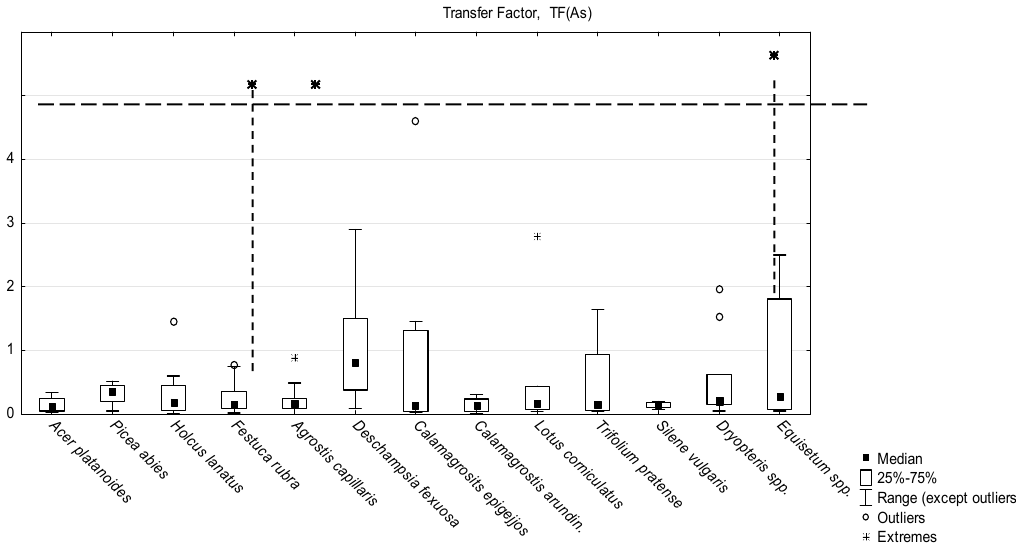
Figure 2. The values of arsenic roots to shoots transfer factor